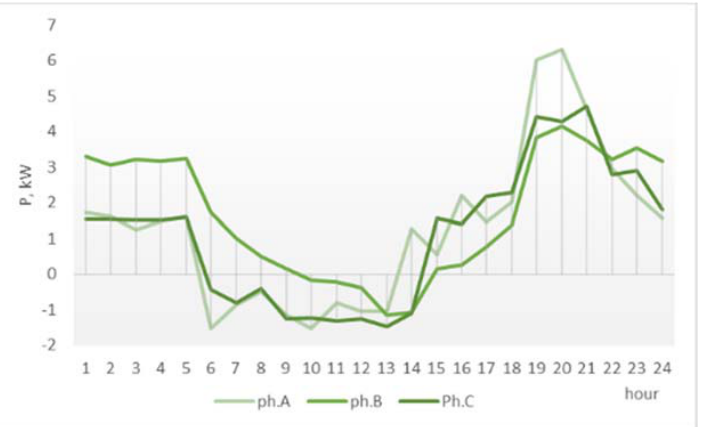
Figure 18. Actual bus demand in network R121 (aggregated demand and generation)—three-phase PSM.